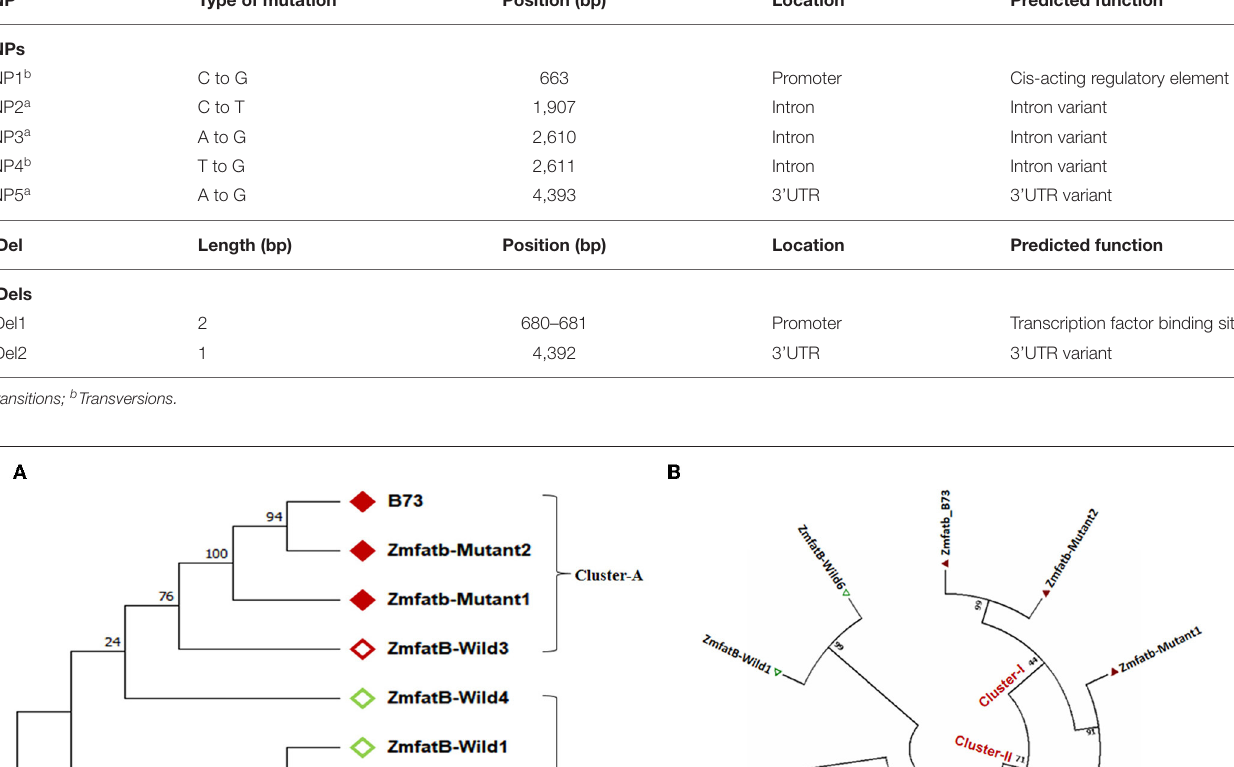
presence of 41 haplotypes existed among the 48 inbreds ( Figure 3